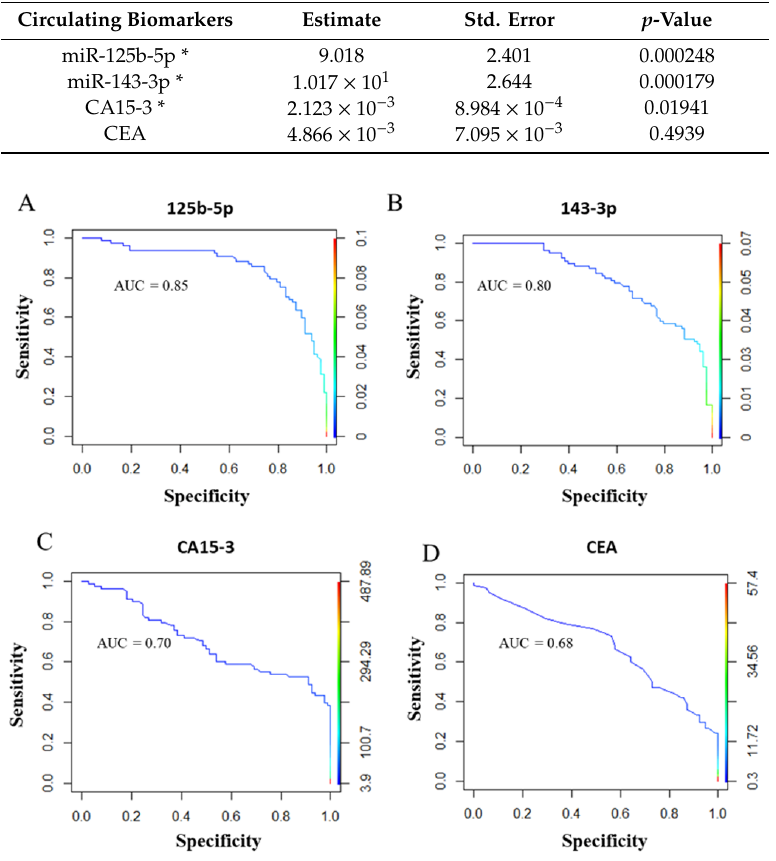
Table 2. Validation III. Logistic stepwise regression on the indicated molecules in a cohort of 78 CTR and 77 BC subjects. * Molecules that significantly ( p < 0.05) estimate the probability of having a tumour.